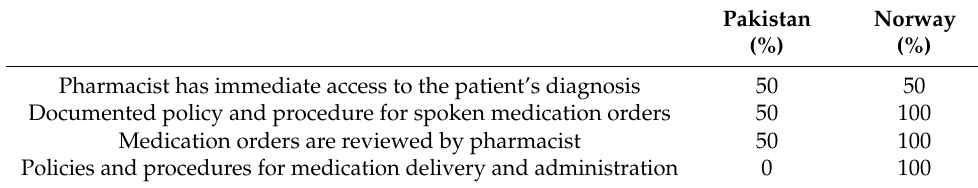
Table 8. Pharmacists’ assessments on medication dispensing and delivery.